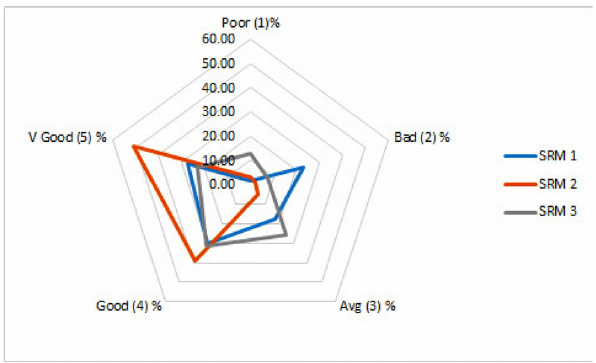
Figure 5. Radar diagram on SRM responses